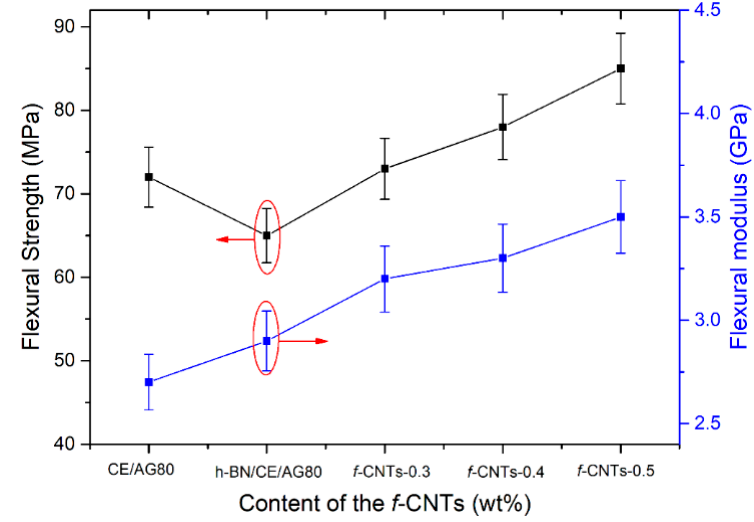
Figure 6. Flexural strength and modulus of resin matrix composites with both h-BN and f -CNTs.